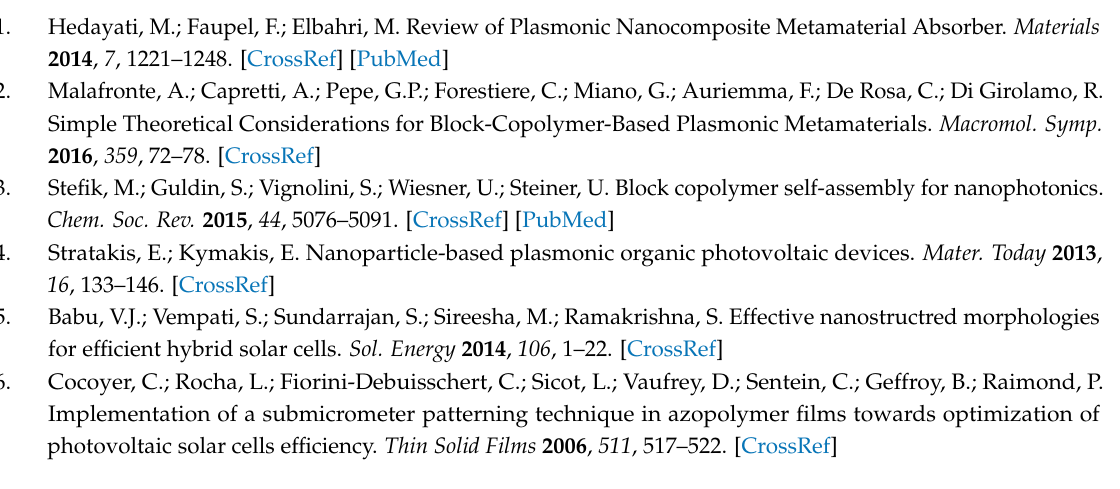
Figure S1: Main steps of the fabrication method; Figure S2: Absorption of the HFs and the GNGs with Au/PVA ratio of 3 wt %, 5 wt %, and 10 wt %; Figure S3: Spectro-goniometer, setup used for the measurement of diffraction efficiency spectra; Figure S4: DE maps of the GNGs with Au/PVA ratio of (a) 3 wt %, (b) 5 wt %, and (c) 10 wt % and the corresponding DE spectra (d); Figure S5: Distributions obtained from numerical optimization for the HF and the GNG at 3 wt %; Figure S6: Effect of nanoparticles localization on the absorption spectra of a HF at 10 wt %; Figure S7: Parameters used for the simulation of HFs with Au/PVA ratio of 3 wt %, 5 wt %, and 10 wt %; Figure S8: SEM images of GNG cross section showing the localization of the nanoparticle at the film surface; Figure S9: Parameters used for the simulation of GNGs with Au/PVA ratio of 3 wt %, 5 wt %, and 10 wt